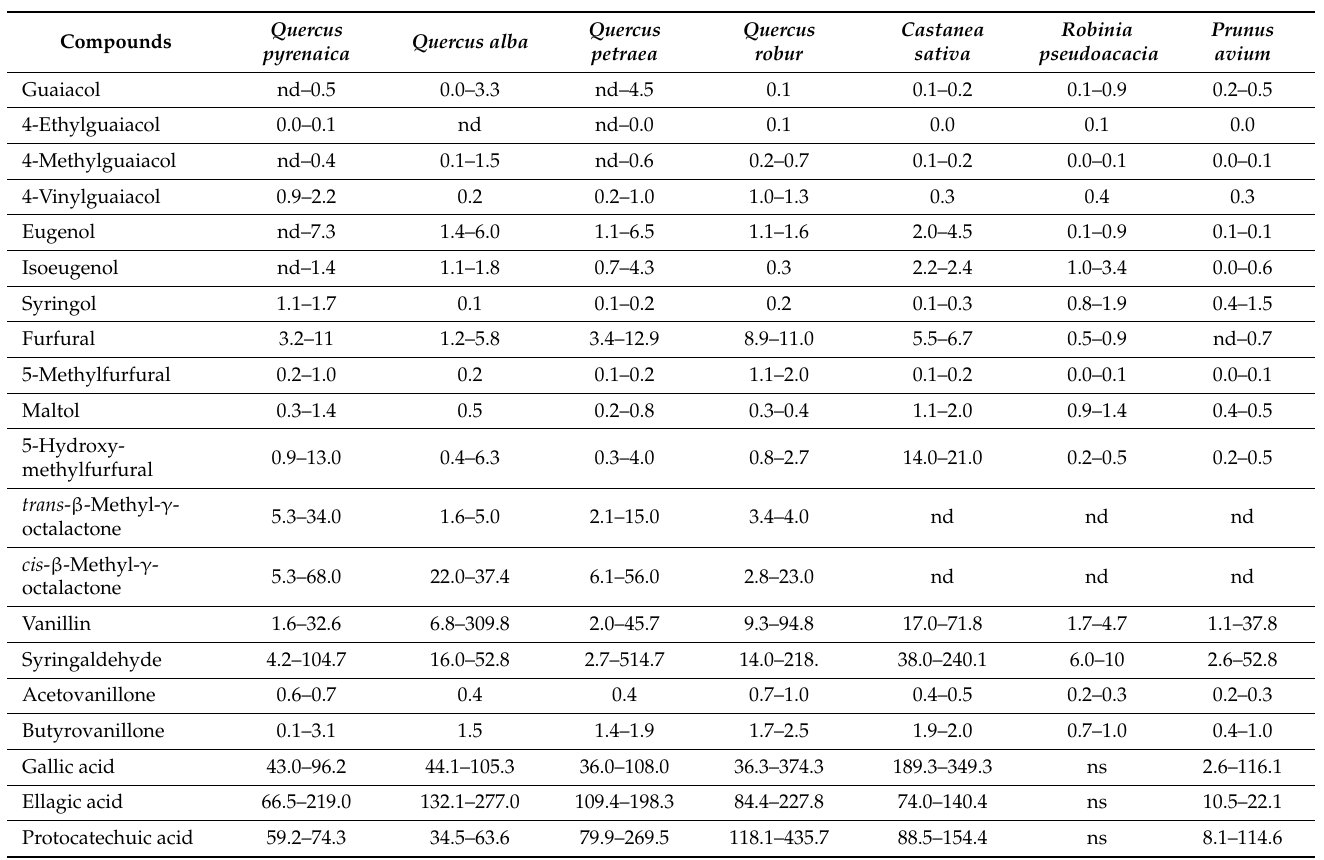
Table 2. Compounds [ µ g/g] found in different wood species, seasoning for 24 months